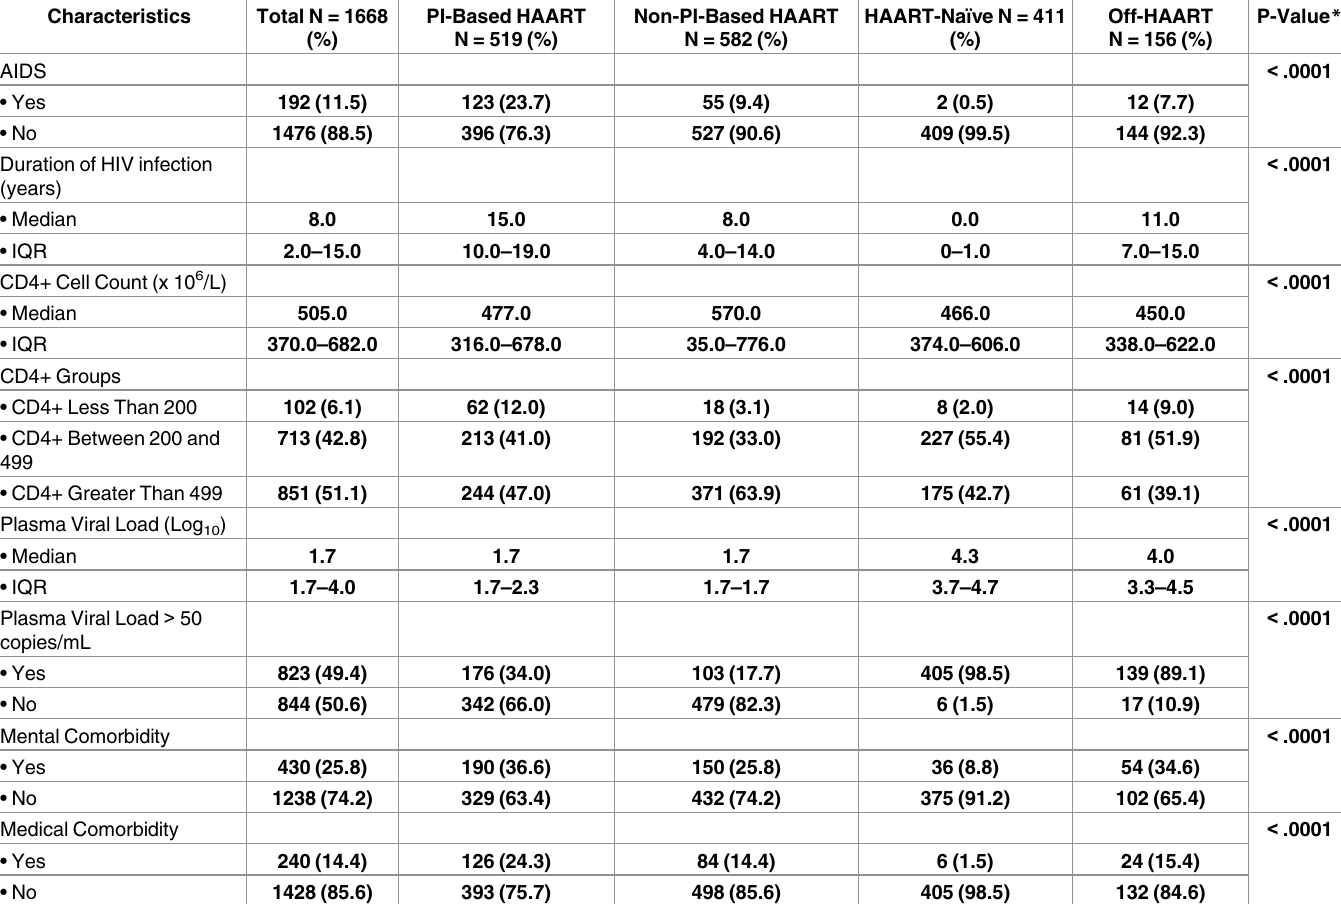
Table 2. Baseline HIV disease indicators and clinical data.